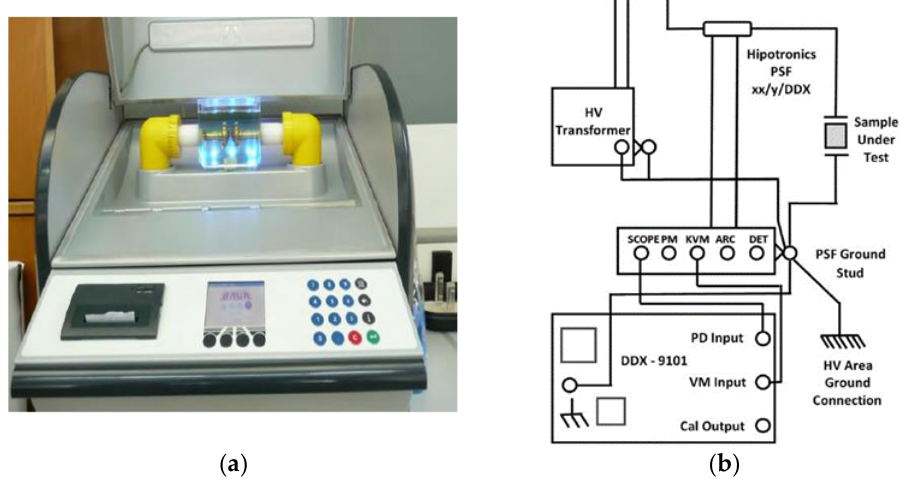
Figure 6. AC BDV and PD experimental devices: ( a ) The BAUR DTA generator with the testing cell; ( b ) the schematic diagram of the PD setup.